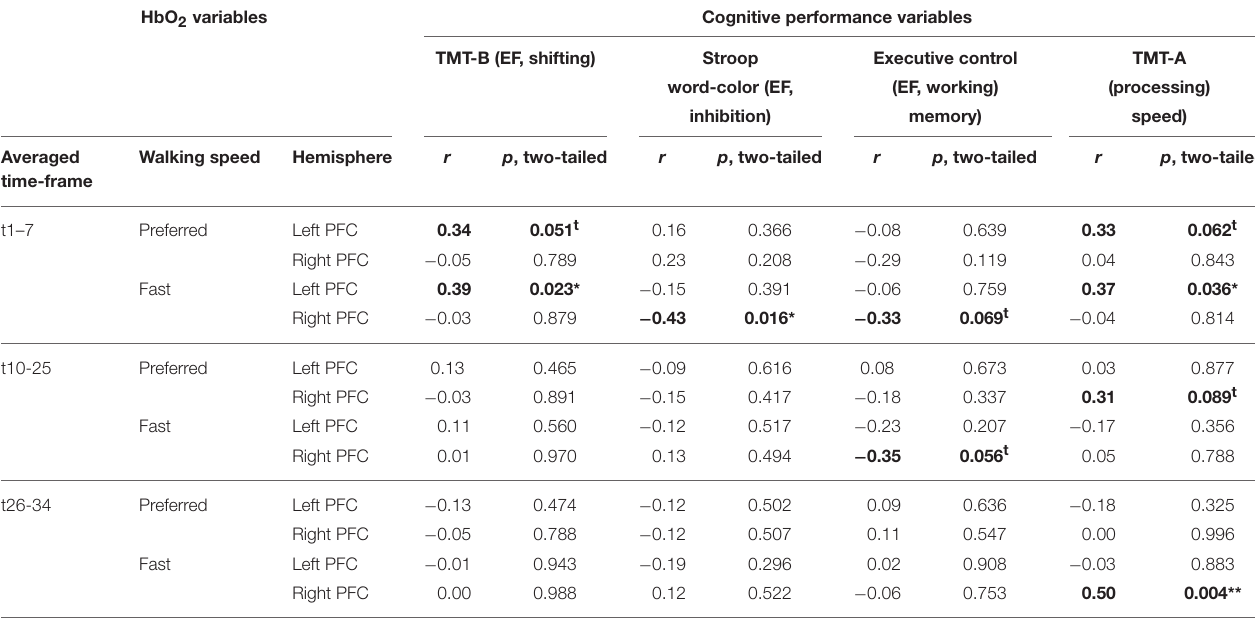
TABLE 5 | Results of Pearson’s correlation analysis between pre-/post-test changes in cognitive performance and PFC activity.